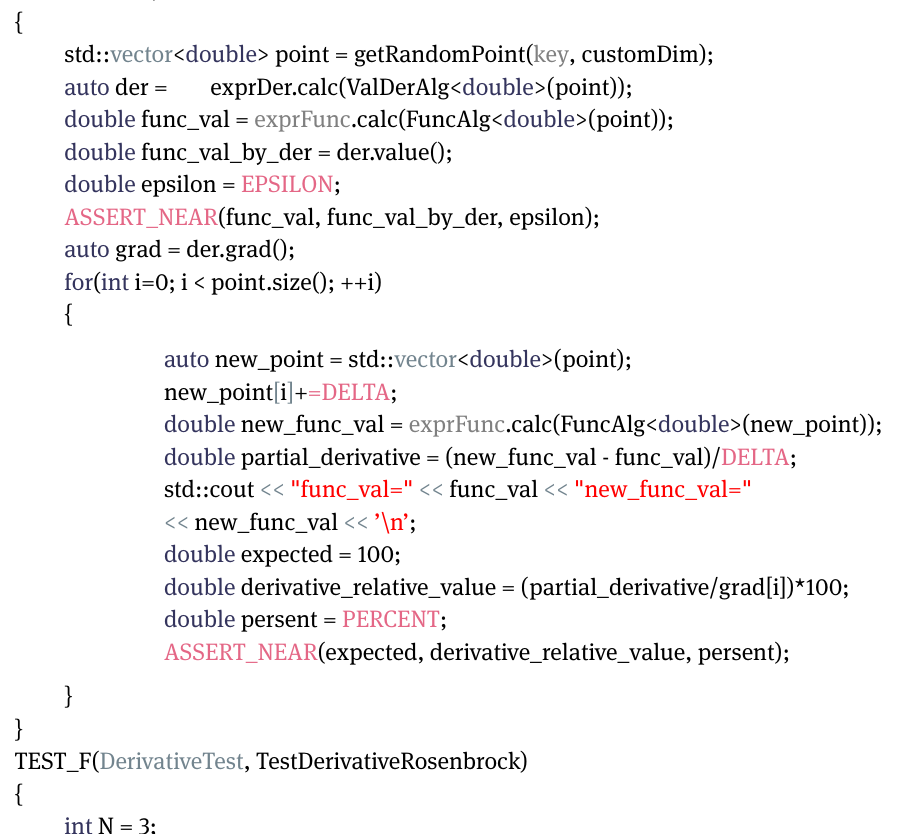
Figure 16: Test the gradient of the Rosenbrock